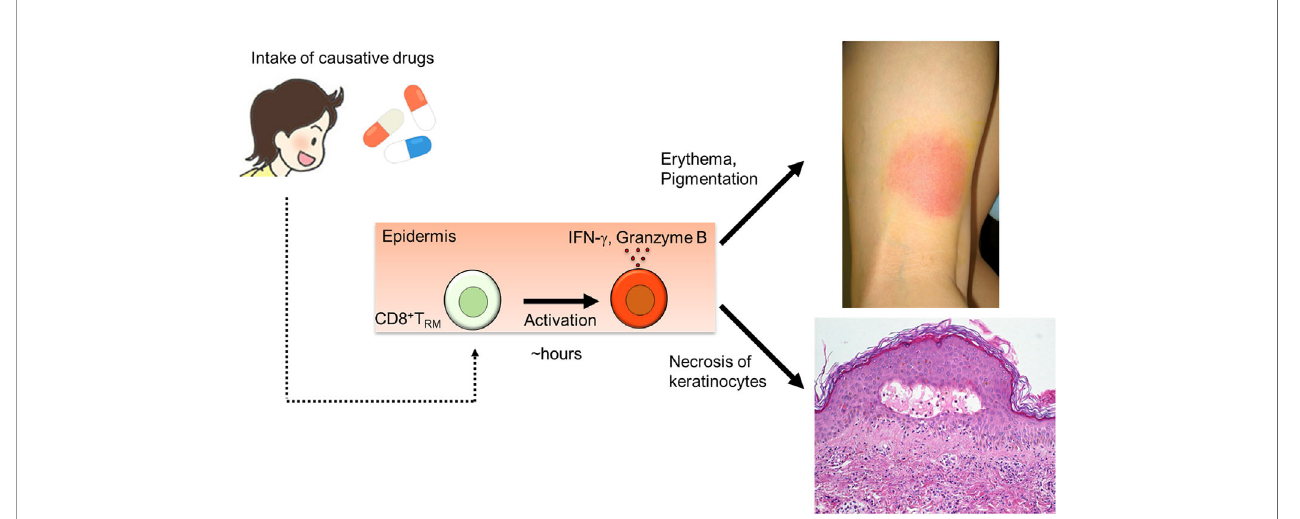
FIGURE 9 | Mechanism of fi xed drug